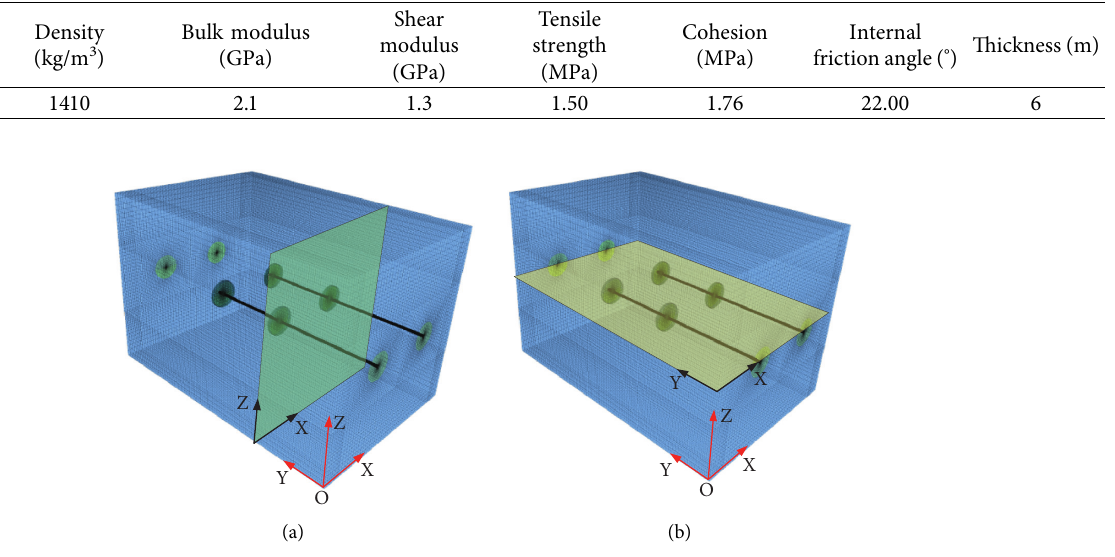
Table 3: Physical and mechanical parameters of the model.